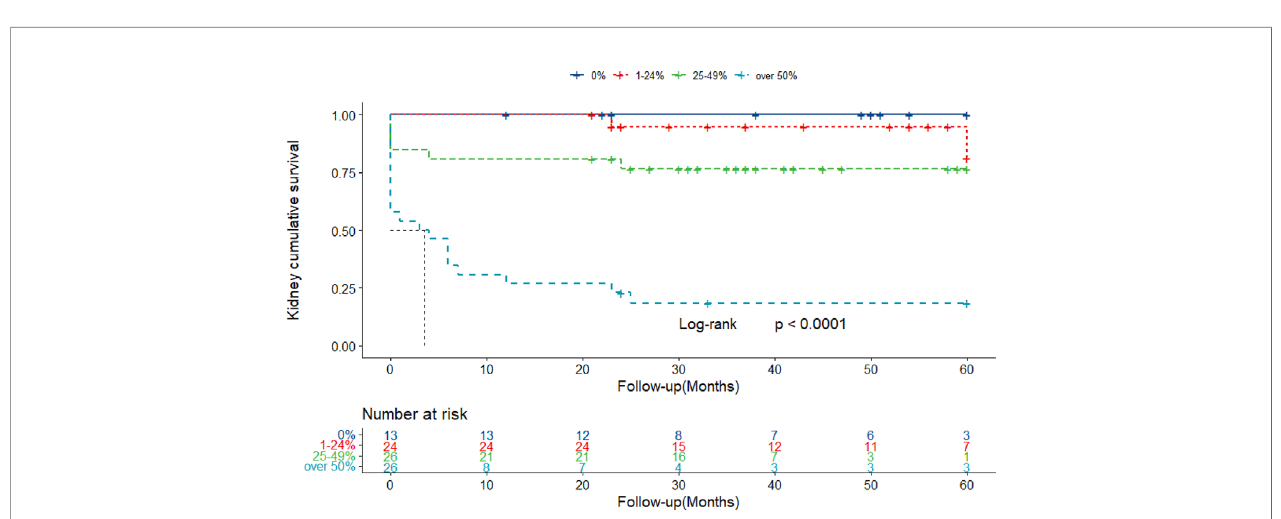
FIGURE 4 | Kaplan – Meier curves of renal survival in IgAN patients with different proportions of crescents. Patients were retrospectively followed up with a mean of 29.5 months. Twenty-nine ESKD cases were collected throughout the follow-up. IgAN, IgA nephropathy; ESKD, end-stage kidney